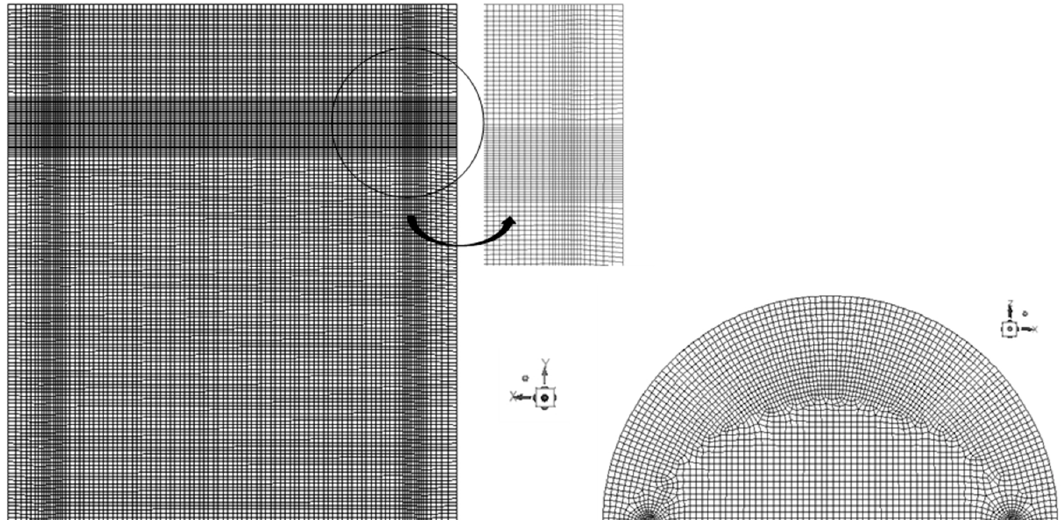
Figure 1. Computational domain of the ladle used for the numerical simulations presented in this study. The two vertical sections indicating the gas injection inlets and the top horizontal section indicating the slag layer are comparatively denser than the remaining mesh domain. The inset shows the mesh density for the slag zone which is di ff erent from the melt zone. The top portion of the mesh (half along the symmetry plane) is shown